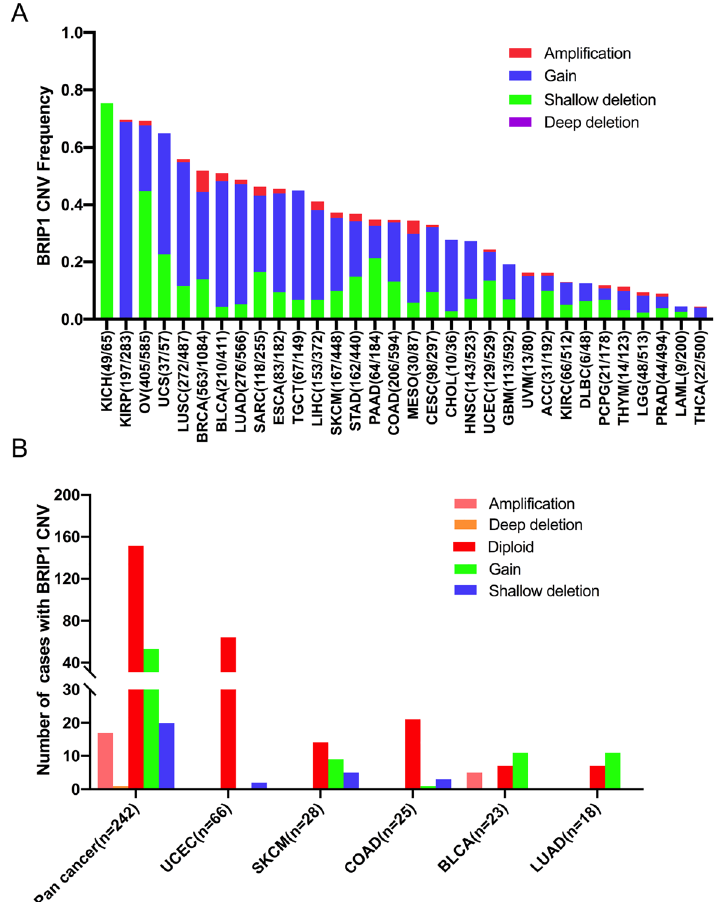
Figure 6. The distribution of BRIP1 CNV among different cancer types. ( A ) The CNV frequency of BRIP1 in 32 tumor types. ( B ) The CNV distribution of BRIP1 in pan cancer and in the top 5 tumor types for the samples with BRIP1 mutations